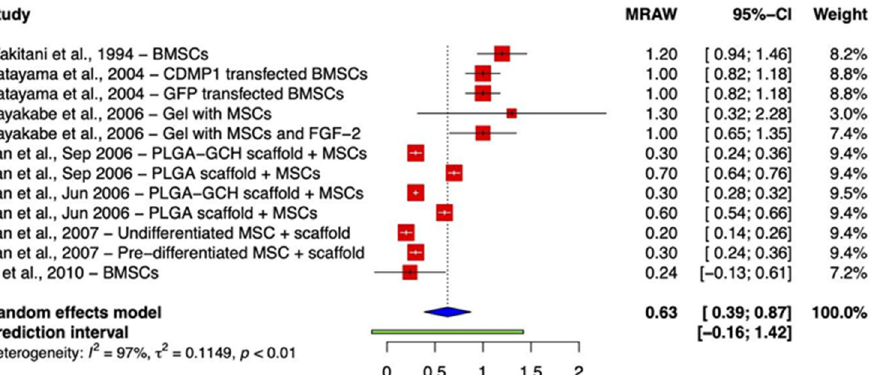
Figure 2. Forest plot on the mean histological integration score after receiving BMSC implant ther- apy, where 0/2 points = both edges integrated, 1/2 = one edge integrated, and 2/2 = no integration. (Abbreviations: BMSC, bone marrow-derived mesenchymal stem cell; CDMP1, cartilage-derived morphogenetic protein 1; GFP, green fluorescent protein; FGF-2, fibroblast growth factor-2; PLGA, poly-(lactic-co-glycolic acid); GCH, gelatin/chondroitin/hyaluronate; CI, Confidence Intervals) [22,24–28,30].